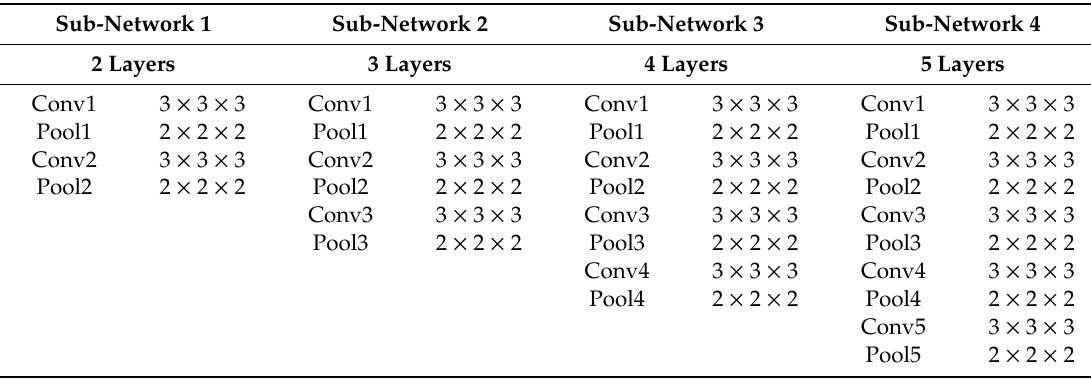
Table 3. The network structures of sub-networks.